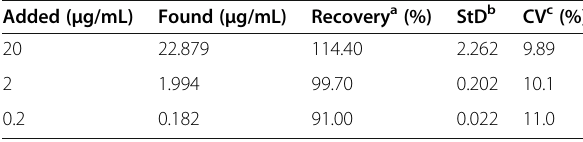
Table.2 Recovery of LBs-LFIA in PEDV-spiked swine fecal samples